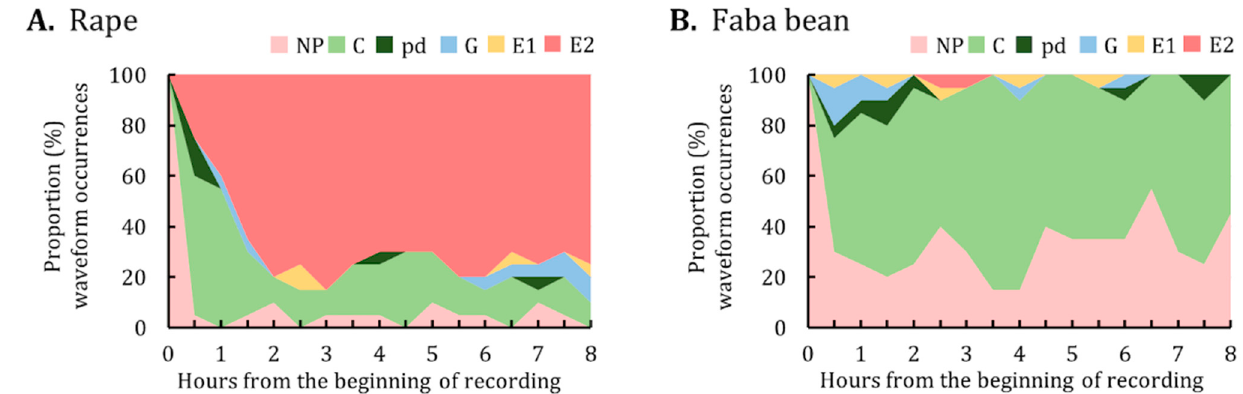
Figure 3. Proportion of waveform occurrences for M. persicae on ( A ) rape and ( B ) faba bean. The graph represents the percentage of individuals in each waveform performed by M. persicae at the end of each 30 ‐ min interval during the 8 ‐ h EPG monitoring period. NP, not probing; C, pathway; pd, potential drop; G, xylem ingestion; E1, phloem salivation; E2, phloem sap ingestion.